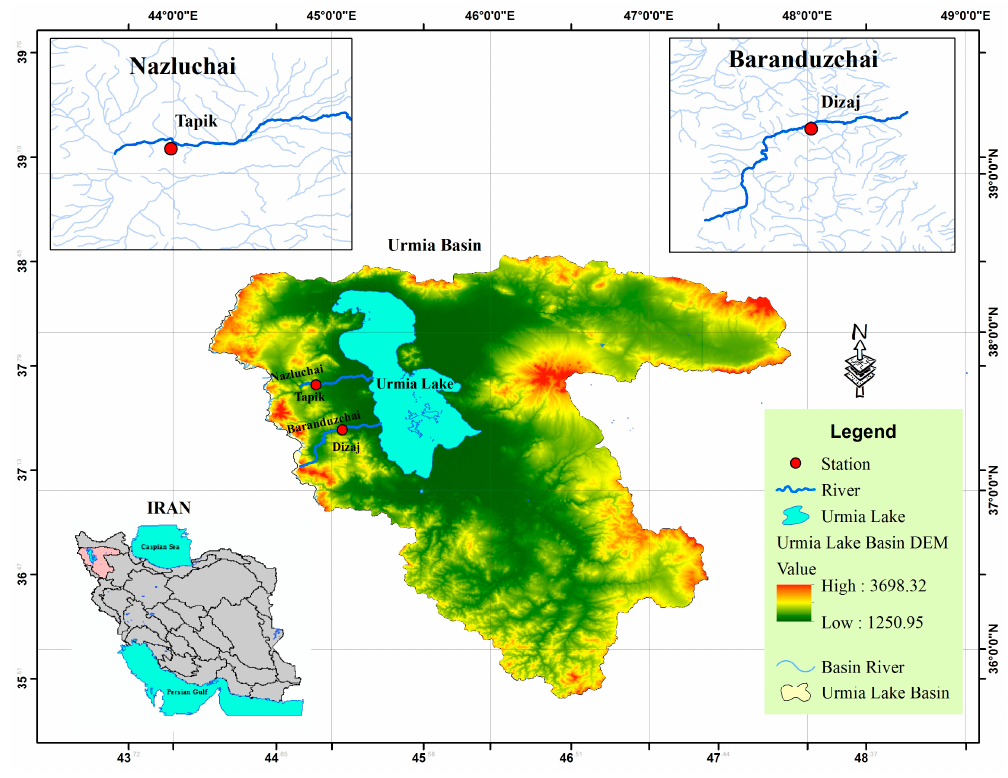
Figure 1. The studied rivers and selected stations.